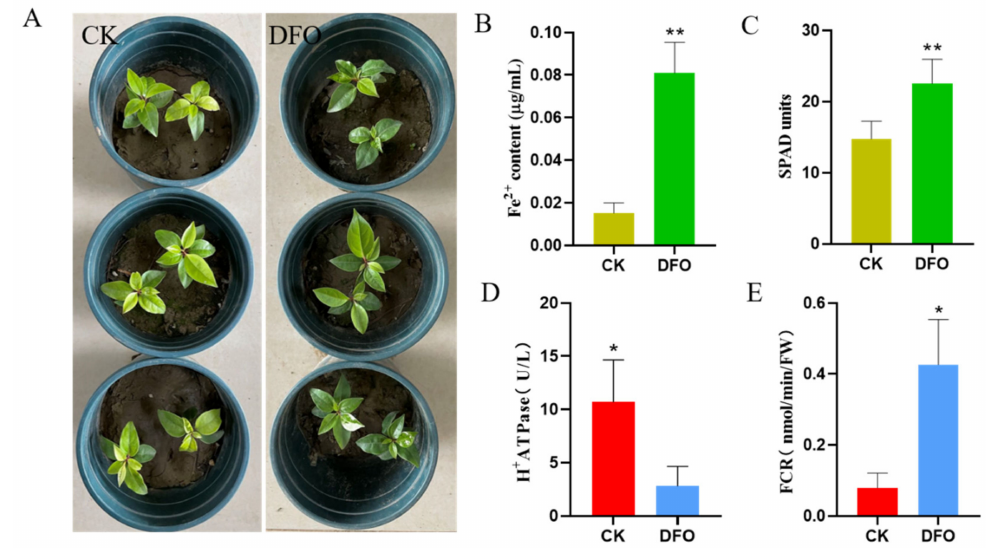
Figure 1. Effects of deferoxamine on the growth of C. camphora under iron deficiency. ( A ) Plant phenotype, ( B ) Fe 2+ content, ( C ) SPAD value, ( D ) H + ATPase and ( E ) ferric chelate reductase. Bars represent the standard error ( n ≥ 3). * and ** represent significant differences at p < 0.05 and p < 0.01 ( t -test),